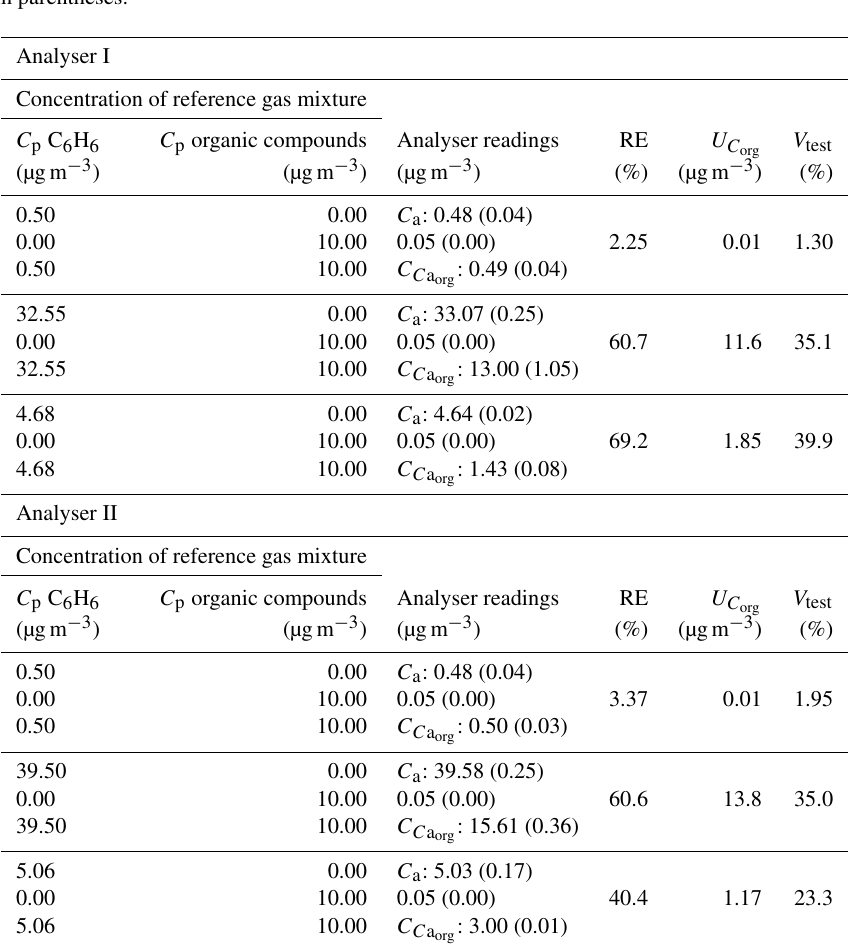
Table 2. Results obtained when conducting the test to evaluate the interference of organic compounds in benzene readings for analysers I and II. Nominal concentrations tested: 0.5 and 40µgm − 3 (according to Standard EN 14662:2005-3) and 5µgm − 3 . Standard deviation of six measurements shown in